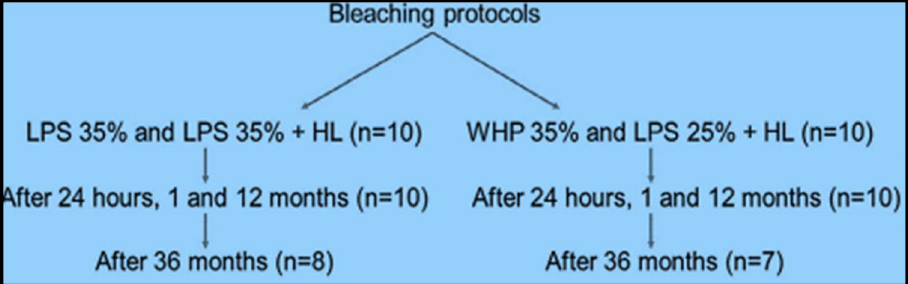
Figure 2. Mondelli et al. bleaching gels protocols.